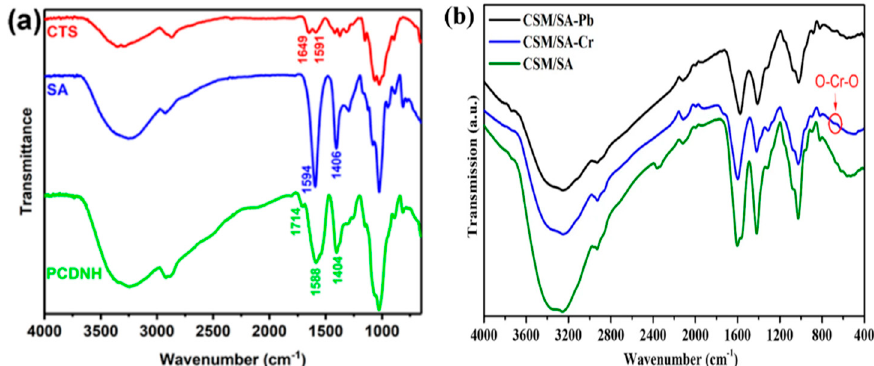
Figure 6. ( a ) FTIR spectra of chitosan (CTS), sodium alginate (SA), and PCDNH, (Reprinted from Ref. [151], Copyright (2022), with permission from Elsevier). ( b ) FTIR spectra of CSM/SA hybrid hydrogel beads loaded with Pb 2+ and Cr 6+ [152].